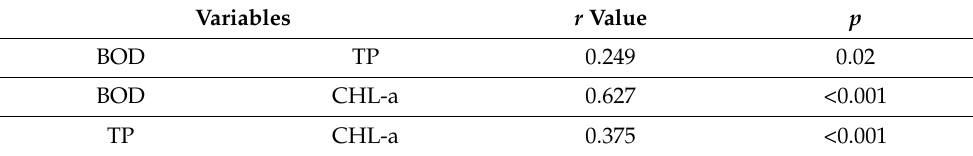
Table 2. Pearson correlation among total phosphorus (TP), biological oxygen demand (BOD) and chlorophyll-a